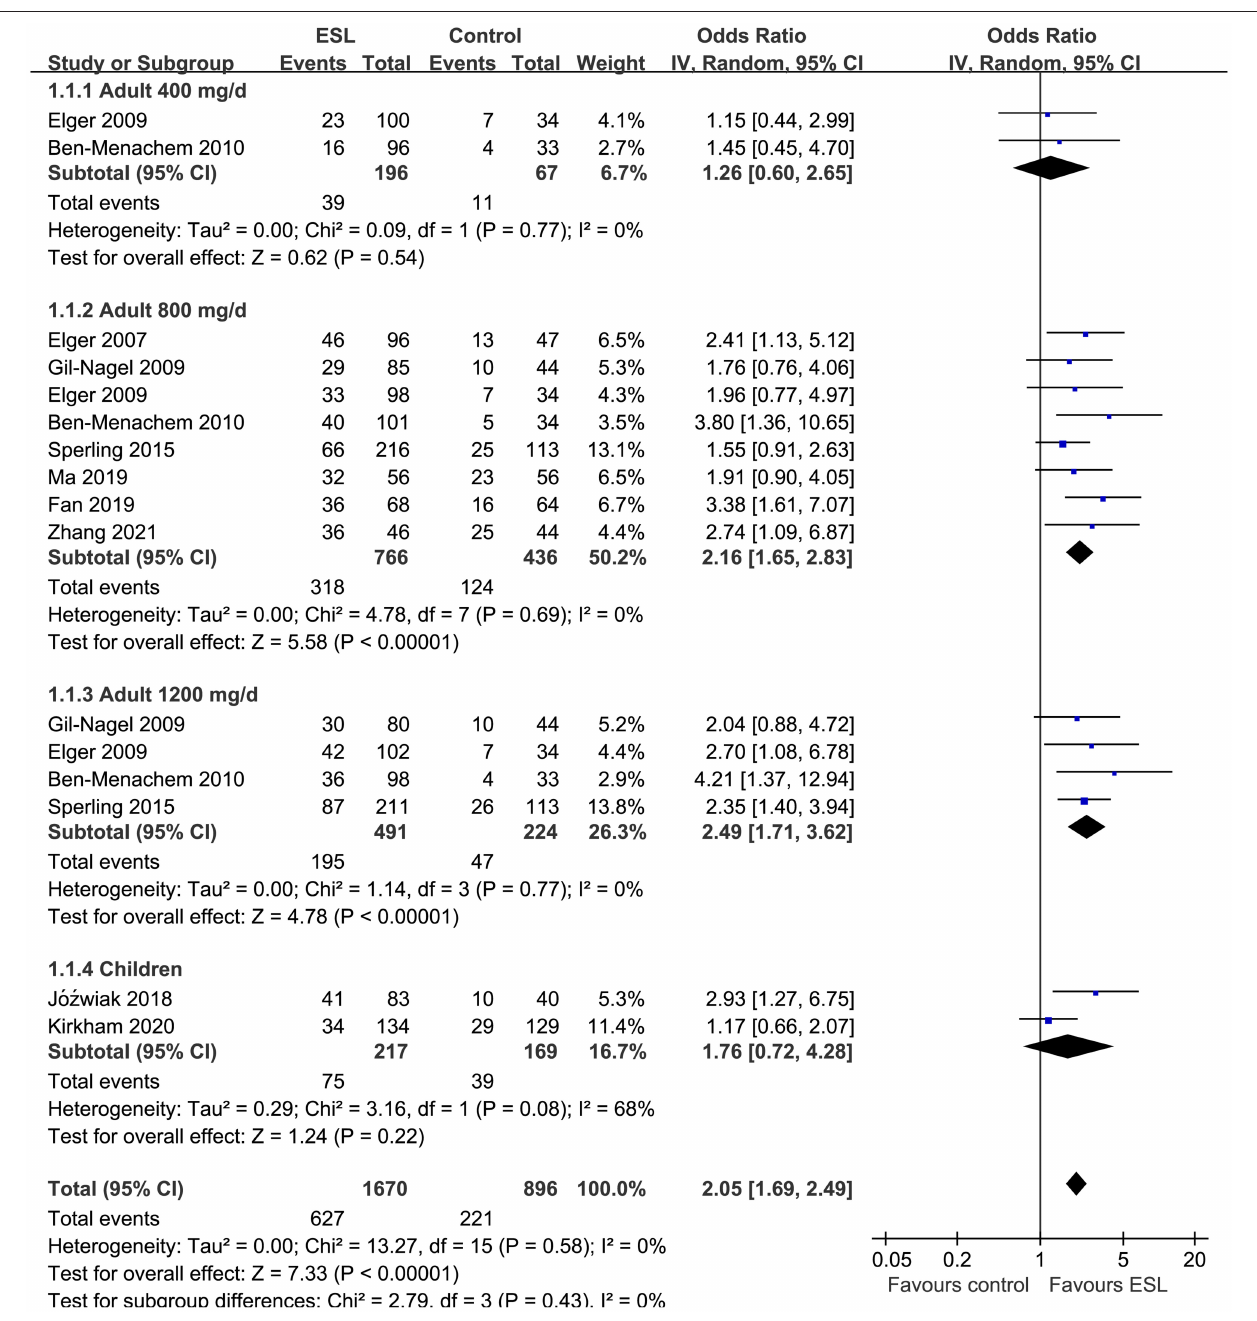
FIGURE 2 | Forest plots for the meta-analysis of the influence of adjunctive ESL on response rate in adults with FOE according to dose of ESL and in children with all doses.